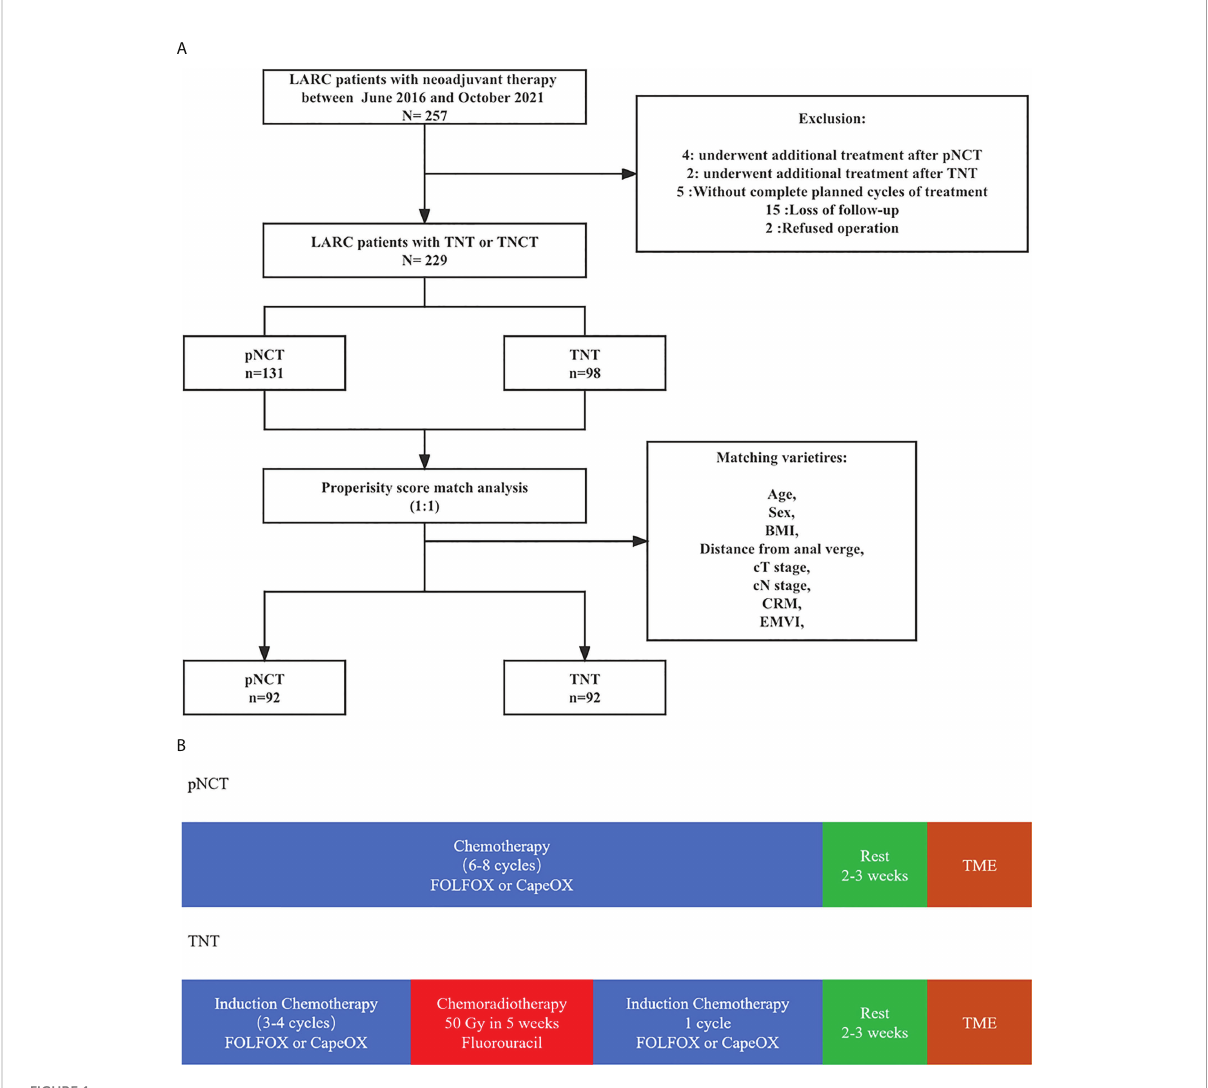
FIGURE 1 The diagram of total study (A) Neoadjuvant treatment; (B) Study population.The diagram of total study (A) Neoadjuvant treatment; (B) Study population. pNCT prolonged neoadjuvant chemotherapy; TNT, total neoadjuvant therapy; BMI, Body mass index; CRM, circumference resection margin; EMVI, extramural vascular invasion; TME, total mesorectal